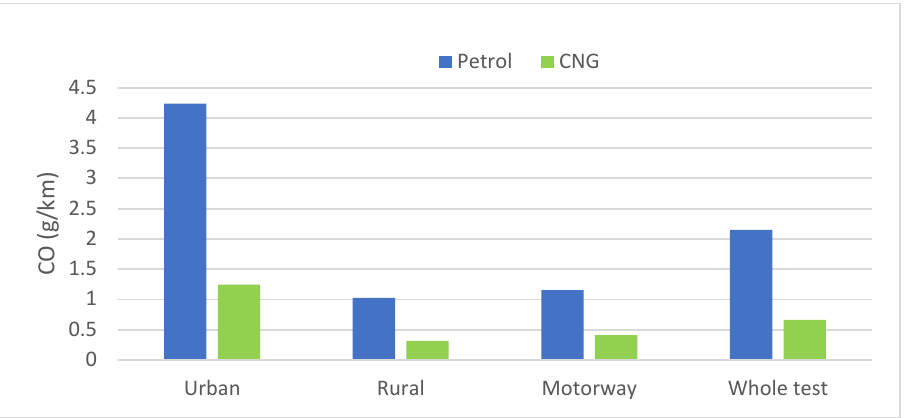
Figure 10. Average CO emission for on-road test.